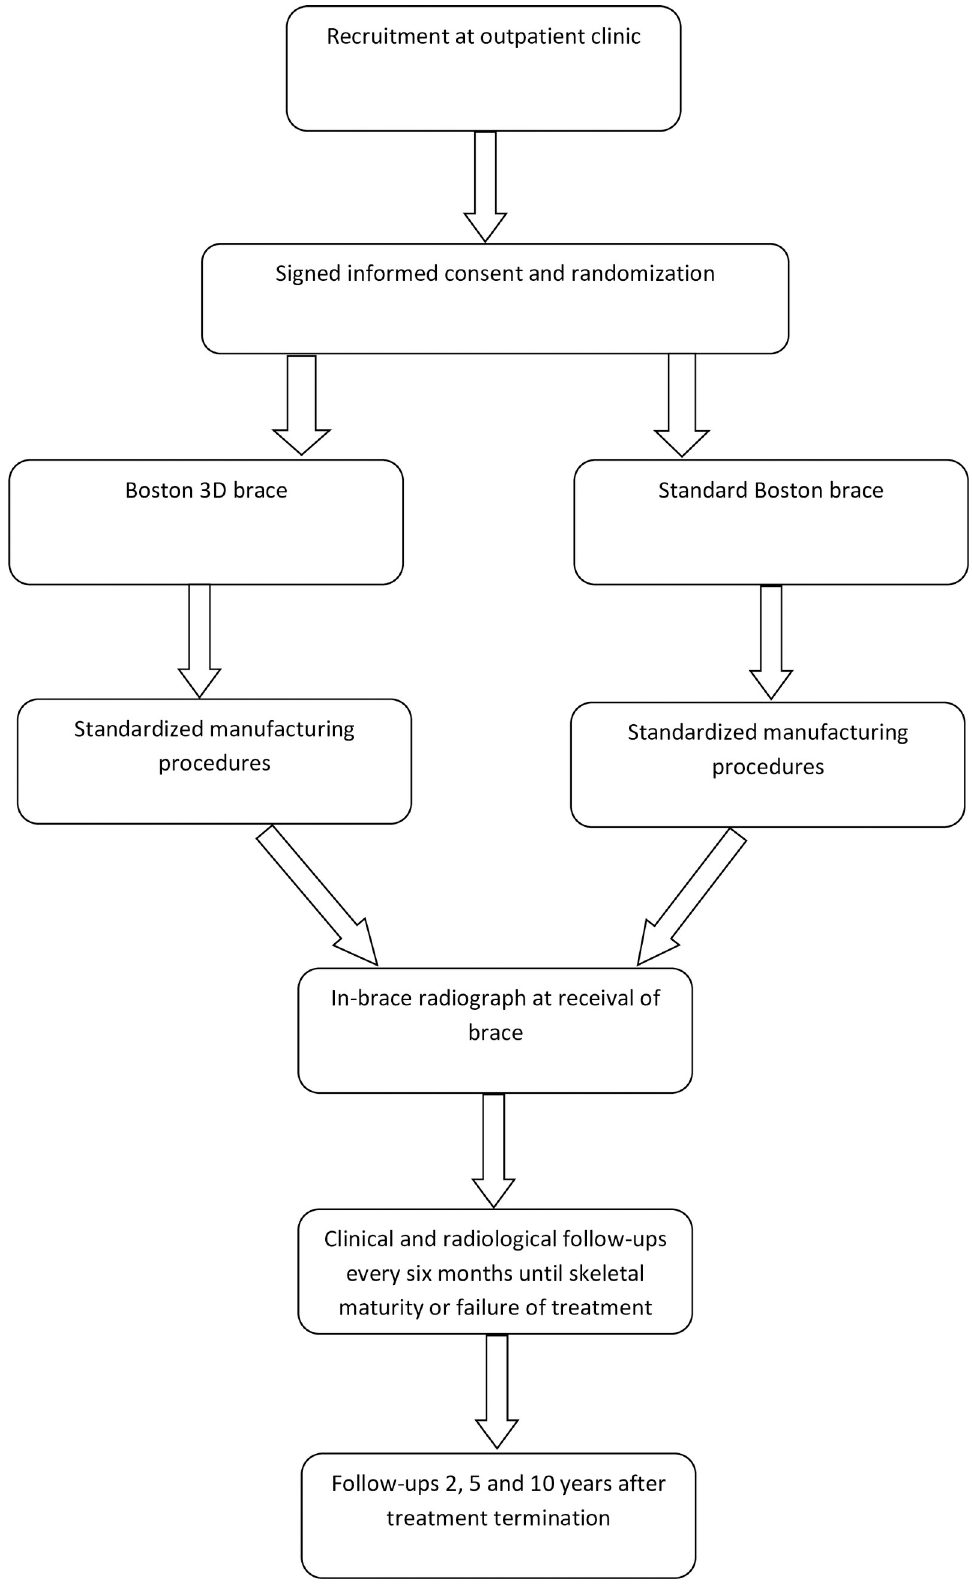
Fig 1. Flow scheme of patient recruitment and